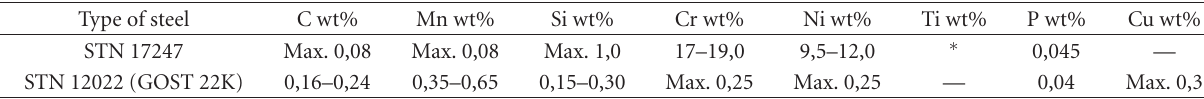
Table 1: Chemical composition of the investigated base material from the steam generators SG35 and SG46 from Jaslovske Bohunice [1– 3, 11].